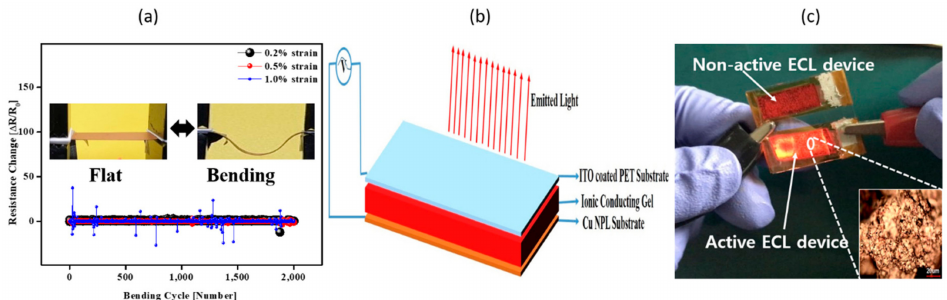
states. ( b ) Schematic diagram of an electrochemical luminescence (ECL) device. ( c ) Practical illustration of ECL device (inset: magnified image of ECL materials over Cu substrate). ITO, indium tin